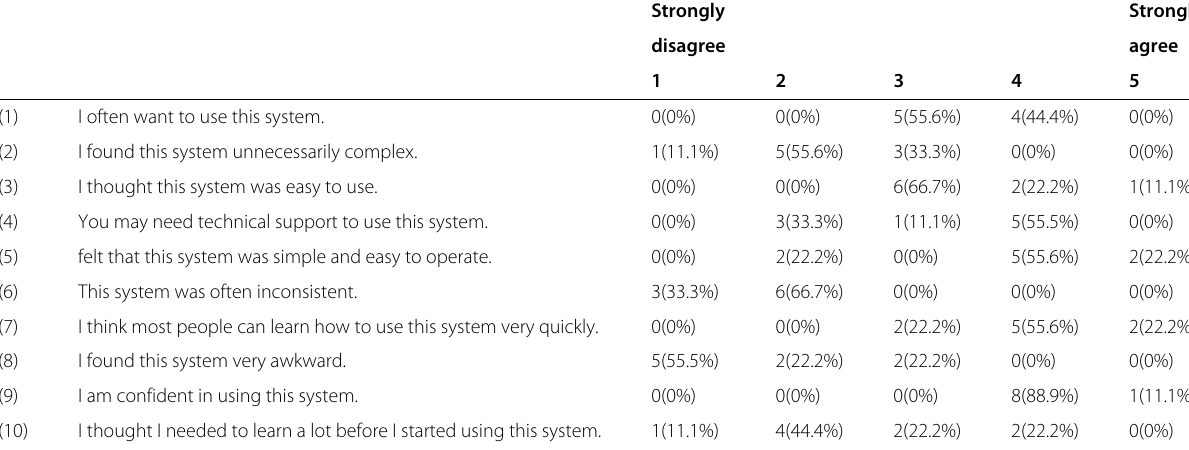
Table 2 Results of usability evaluation using SUS